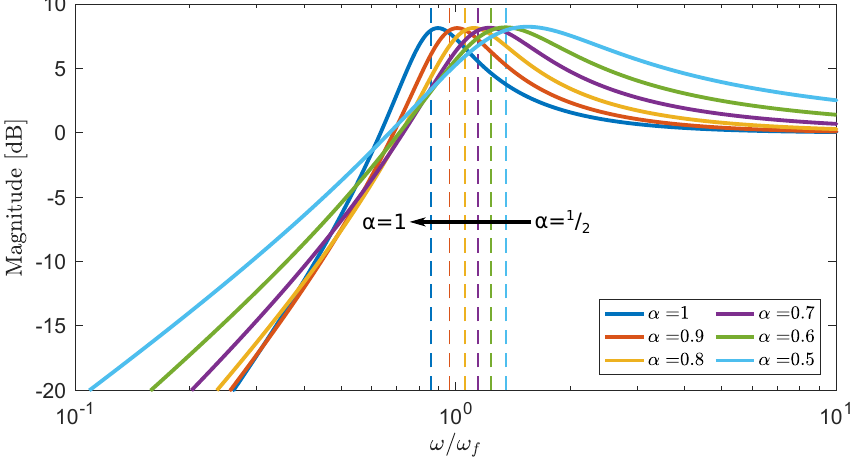
Figure 6. Frequency responses of optimal fractional-order attenuators with ζ f , α = 1 = 0.2. Dashed lines indicate the corner frequencies ω f of attenuators with corresponding α